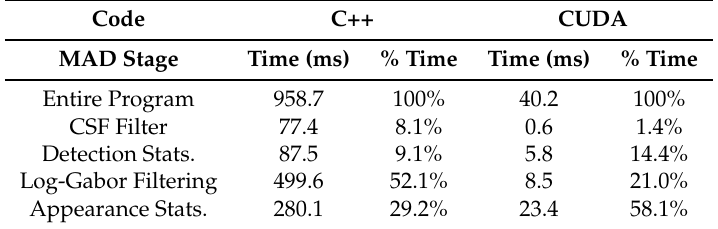
Table 2. Results on the main experiment on the primary test system (CSIQ database; Titan Black).